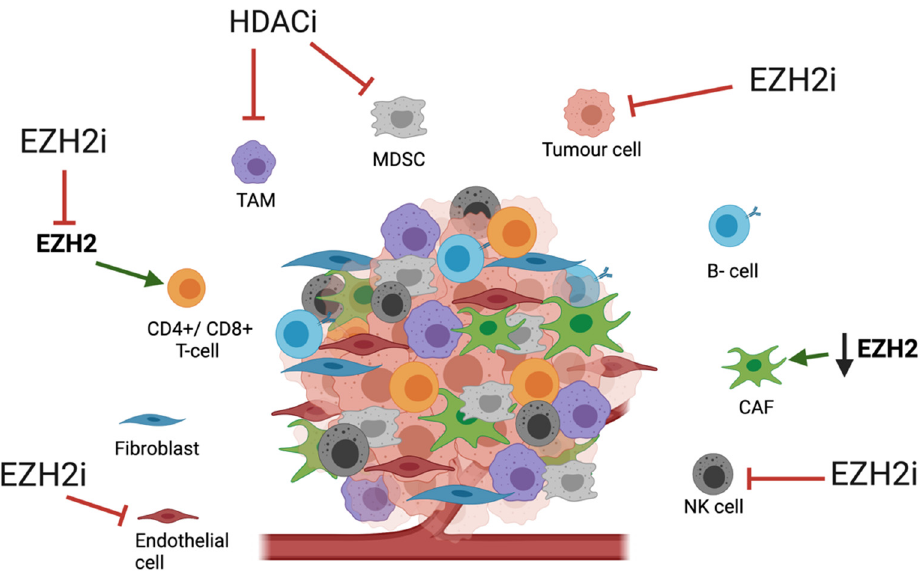
Figure 1. Potential effects of HMEi in the tumour microenvironment. The TME is comprised of numerous cell types which are crucial in promoting tumorigenesis and drug resistance but may be uniquely susceptible to HMEi. EZH2: Enhancer of zeste homolog 2, HDAC: histone deacetylase, TAM: Tumour associated macrophage, CAF: Cancer associated fibroblast, MDSC: myeloid-derived suppressor cells, NK cell: Natural Killer cell. Red arrow: downregulation/inhibition, Green arrow: upregulation. (Created with BioRender.com, accessed on 27 June 2021).